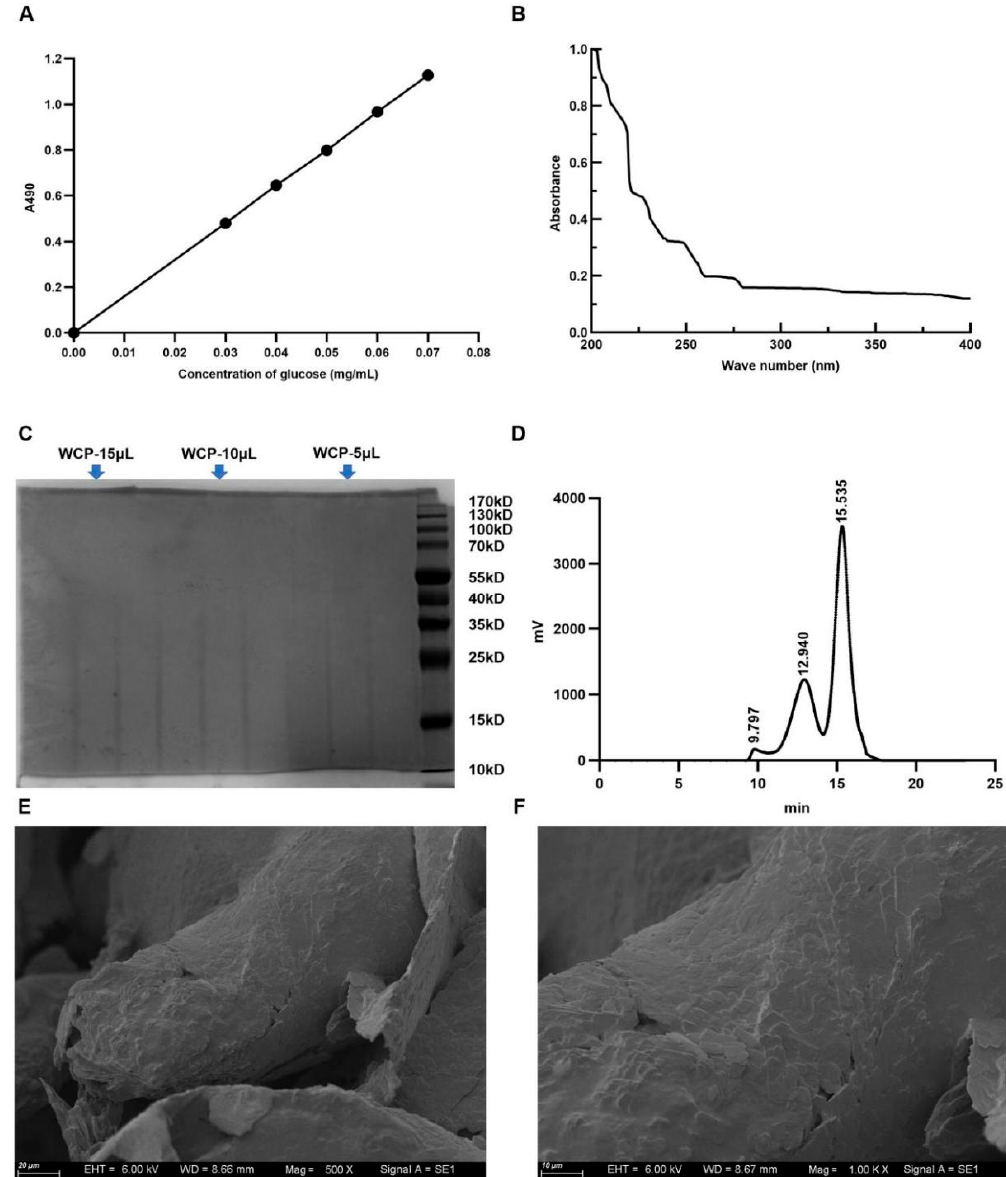
Figure 1. The total sugar content, purity, average molecular weight, and microstructural features of WCP. ( A ) The total sugar content in the WCP was measured by phenol-sulfuric acid method, using glucose as a standard control. ( B , C ) The purity of WCP was determined by UV spectrum and SDS-PAGE gel electrophoresis. ( D ) The average molecular weight of WCP was measured by HPGPC. ( E , F ) The microstructural features of WCP were observed by scanning electron microscopy (500 × , 1000 × , scale bar = 20 µ m and 10 µ m,